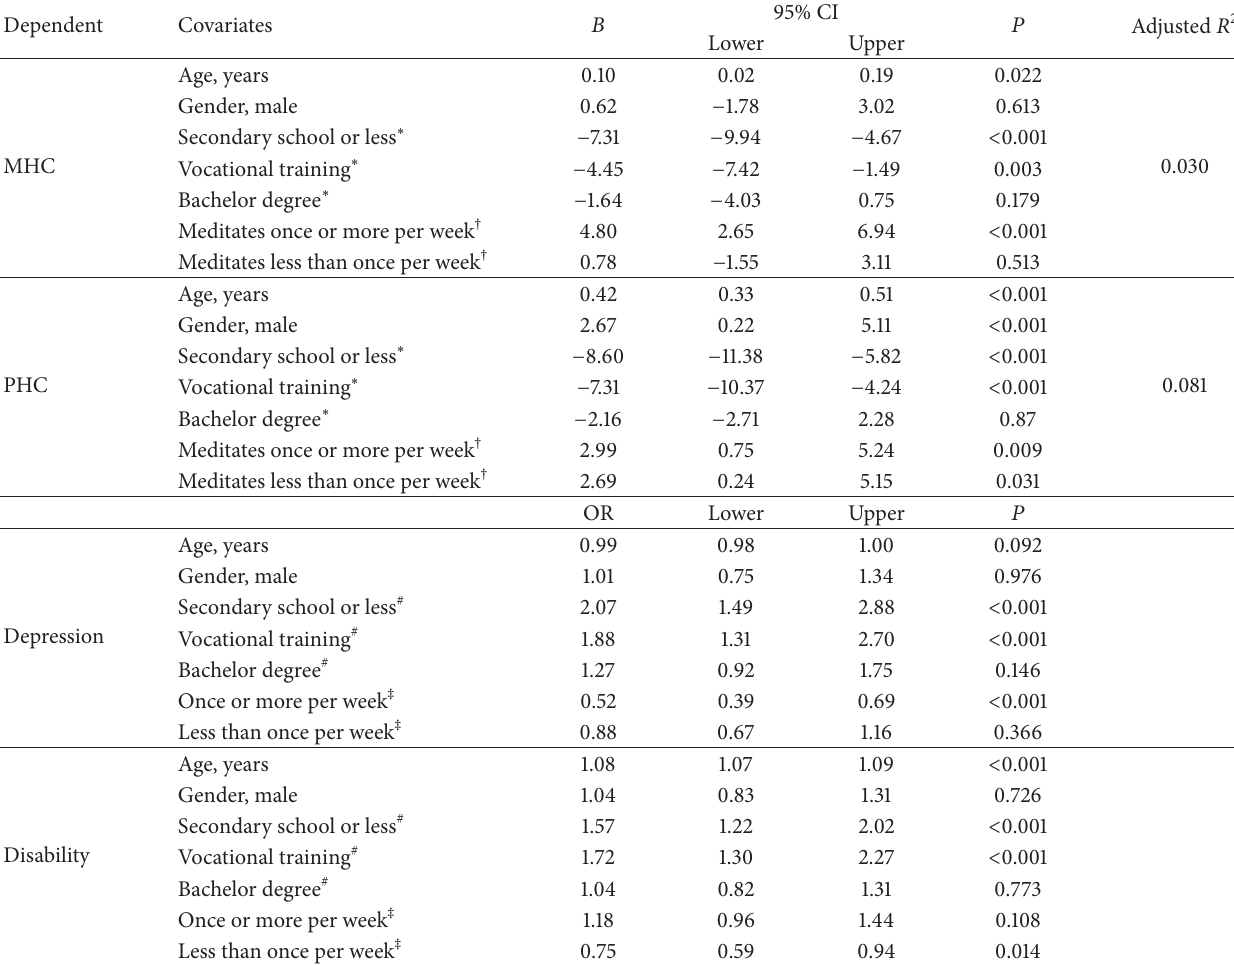
Table 3: Predicting the PHC, MHC, and depression with meditation